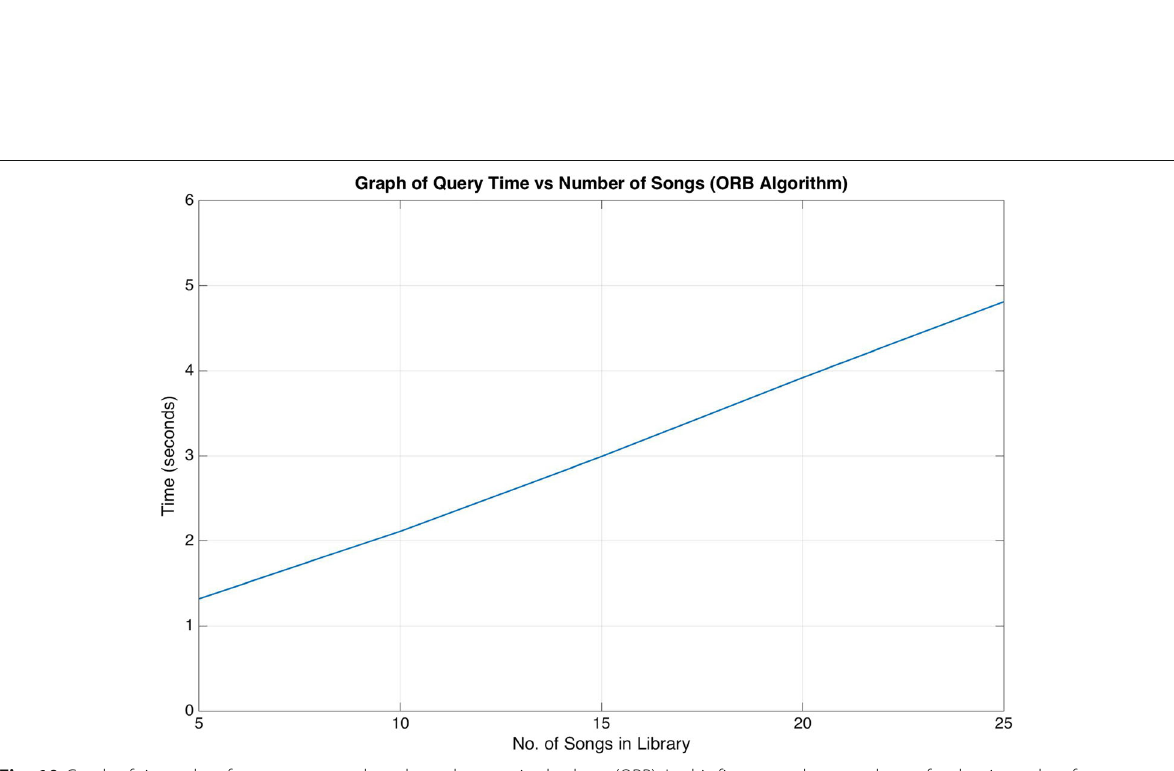
Fig. 10 Graph of time taken for query to search and match songs in database (ORB). In this figure, results were shown for the time taken for a query to be searched and matched. This was done for libraries of songs. This was done for the ORB prototype. The results showed a linear relationship, but it was seen that it had a larger time difference for the query process to be executed as the song library